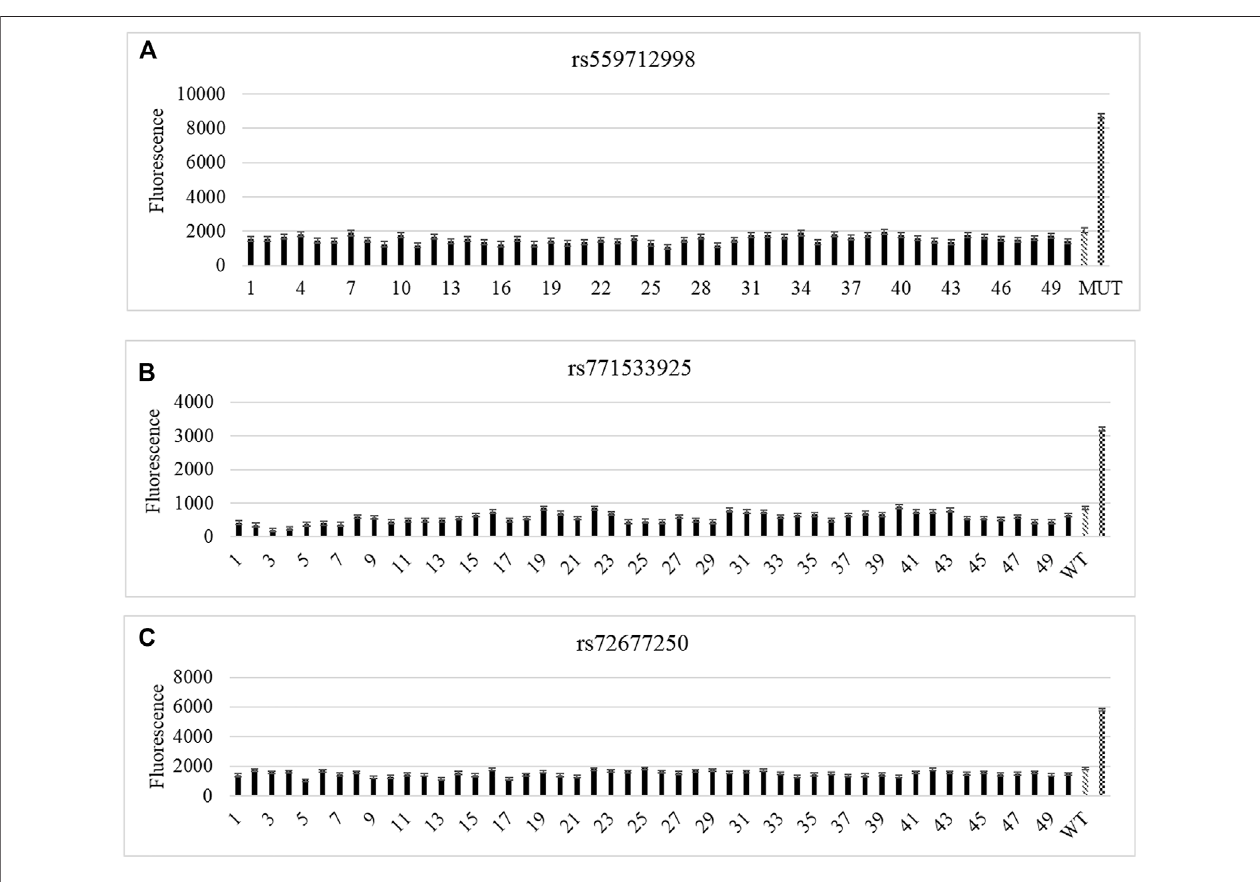
FIGURE 4 | CRISPR-Cas12a analysis of TTN gene mutation loci in sporadic samples. (A – C) CRISPR-Cas12a test results for rs559712998, rs72677250 (A), rs771533925 (B) , and rs72677250 (C) .